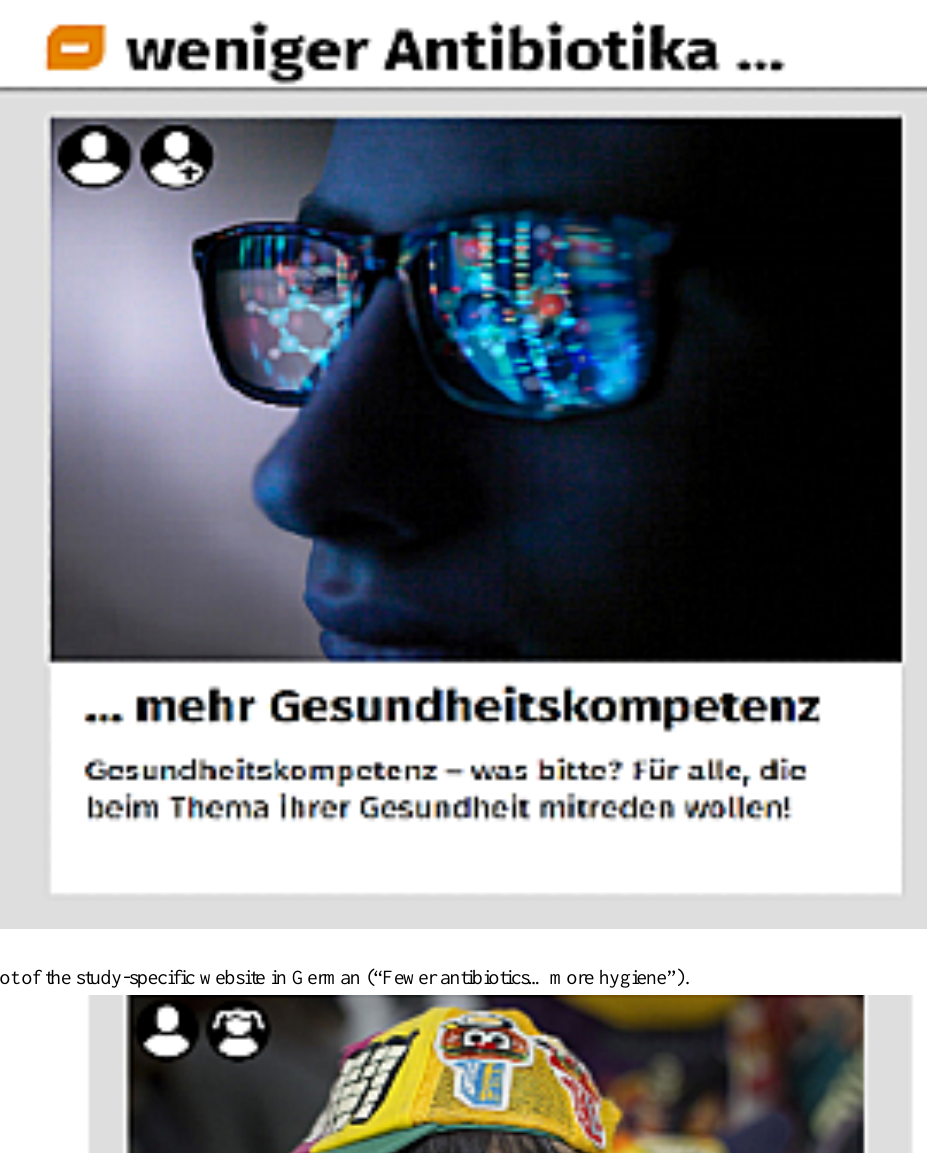
Figure 1. Screenshot of the study-specific website in German (“Fewer antibiotics…more health literacy”).